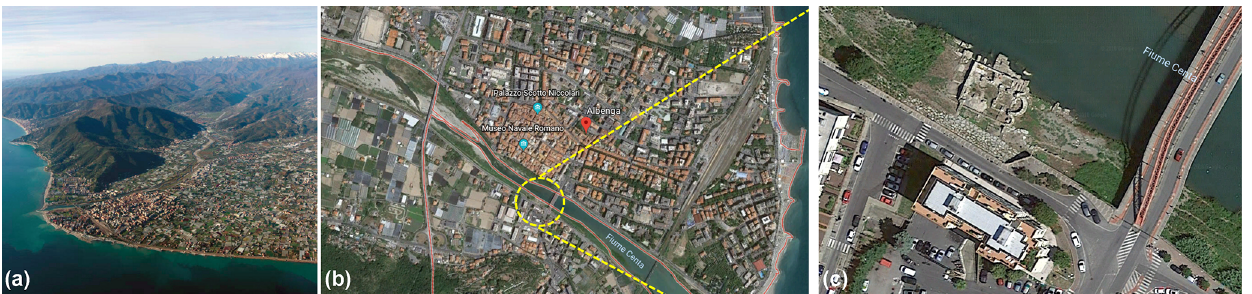
Figure 1. Albenga case study: bird’s eye-view of the coast (a) ; a sequence of the cultural heritage sites in the cultural landscape system of Albenga (b) ; close-up on the church of St. Clemente archaeological site found in the riverbed of the river Centa.